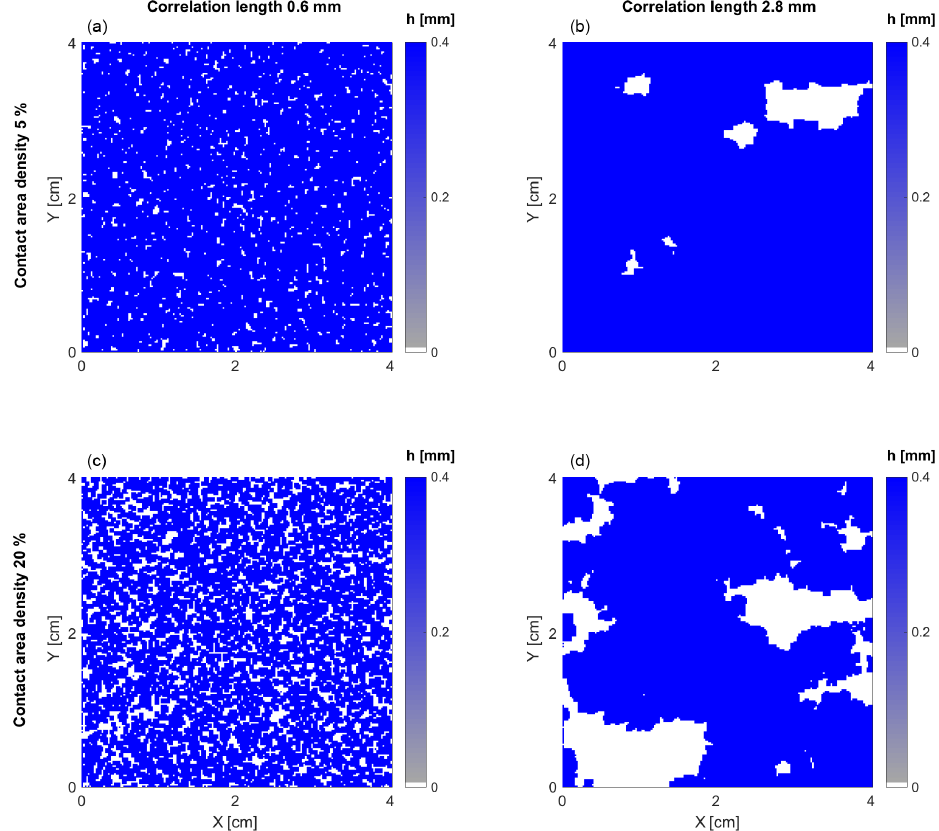
Figure 7. Fracture with binary aperture distributions derived from fracture models A to D in Fig. 5. The aperture in the open fracture regions is set equal to the mean value (0.4mm) of the aperture distribution shown in Fig.